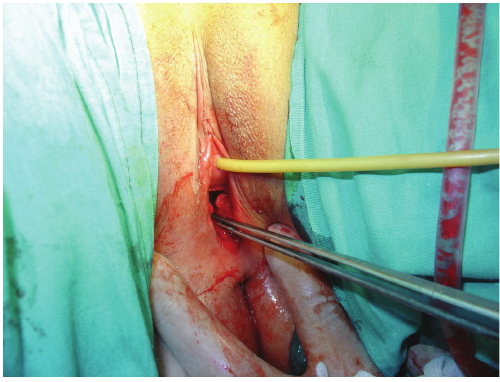
Figure 1: Neovaginal space created by blunt dissection. Figure 2: Right rudimentary uterine horn (black arrow) with normal tube and ovary.